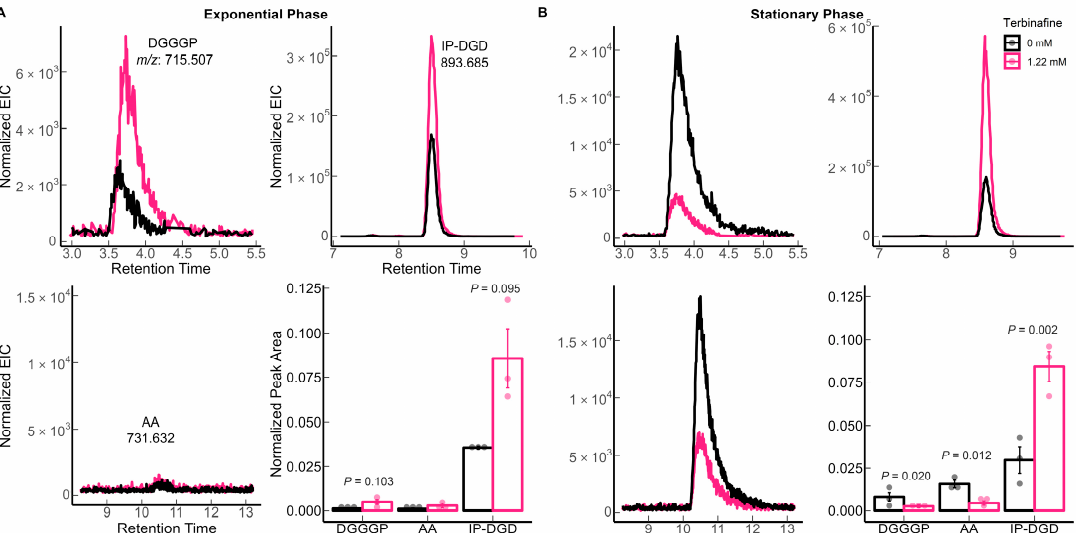
Figure 4. Effect of terbinafine on the bilayer-forming membrane lipids (DGDs) of S. acidocaldarius : Extracted ion chromatograms and relative quantification of DGGGP (digeranylgeranylglyceryl phosphate), AA (archaetidic acid), IP-DGD (inositol phosphate dialkyl glycerol diether) in ( A ) exponential phase and ( B ) stationary phase of growth. Error bars represent the standard error of the mean and p -values are indicated for each lipid species. The dots represent biological replicates. The theoretical m / z [M-H] – values are listed in the figure. The extracted ion chromatograms (EICs) were normalized to the amount of lipids using the internal standard DOPG.